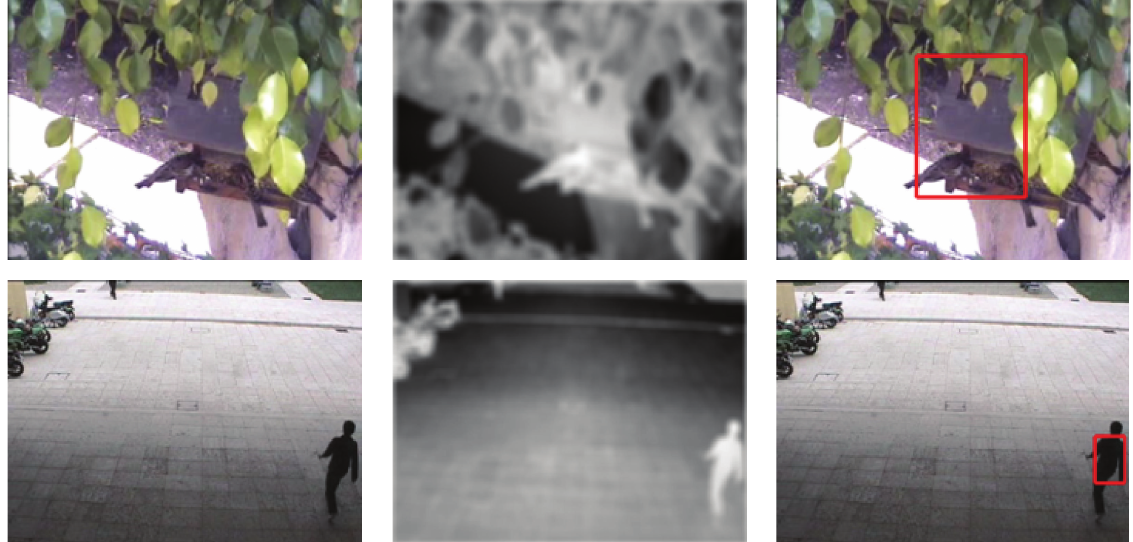
Figure 6: Videos (5) and (6): results using modified frequency tuned spatial model I.